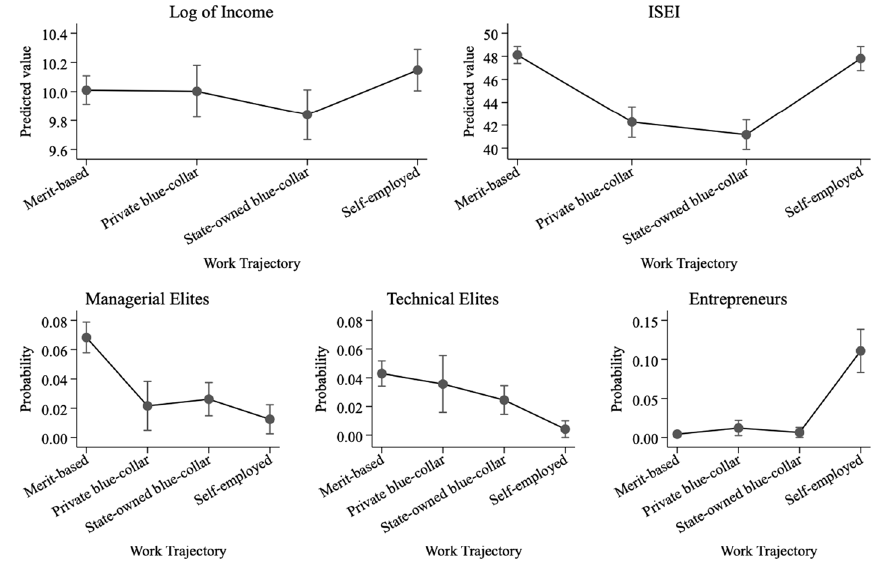
Fig. 5 Relative effects of the four typical work trajectories on status